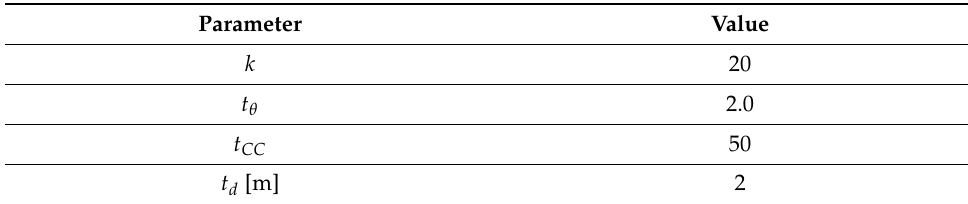
Table 1. Parameters used for segmentation of the point